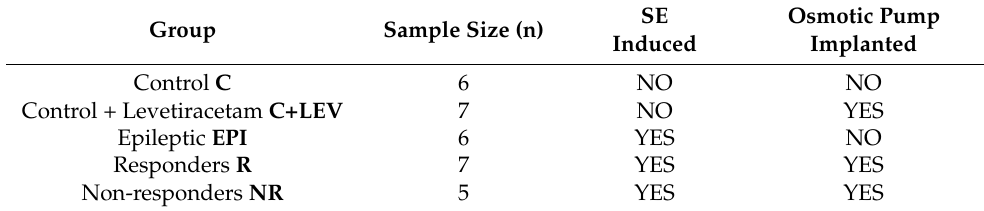
Table 1. Experimental conditions for each group.